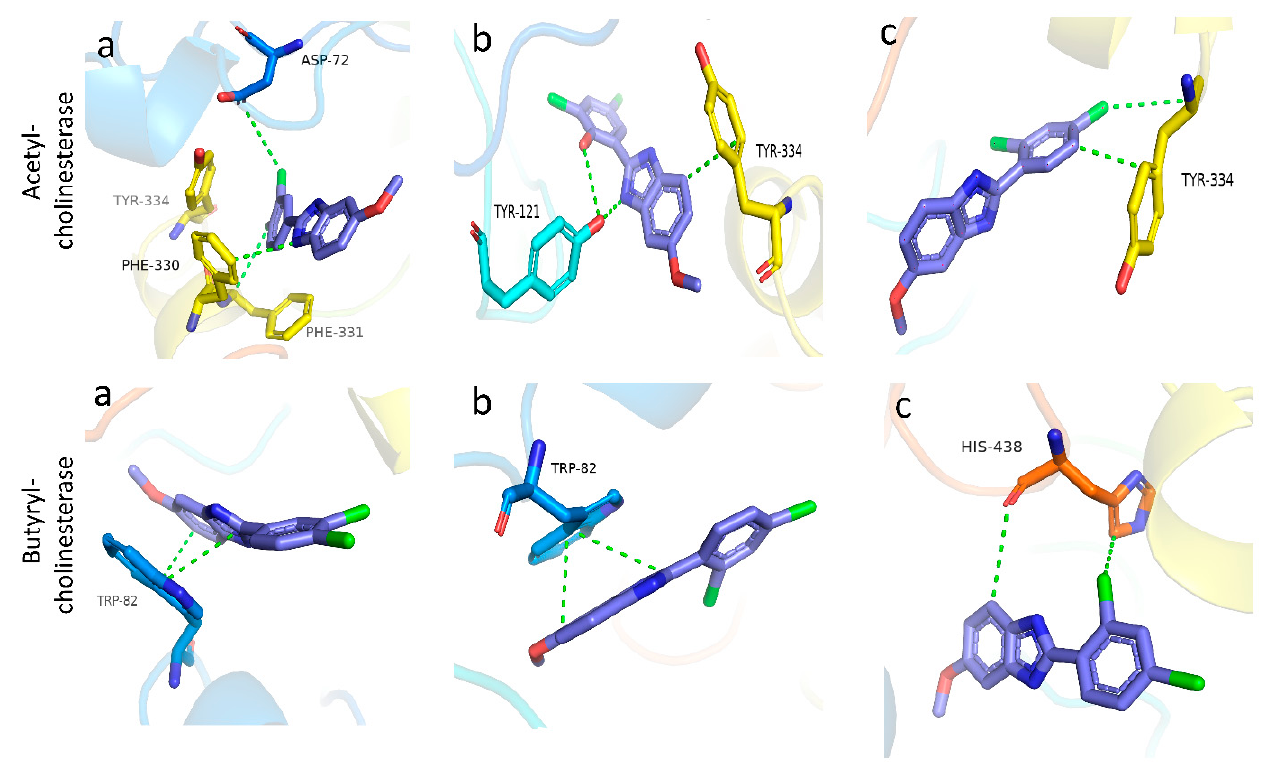
Figure 2. Docking interactions of the most active compound in the series, is for 3, 10 & 11 against the AChE ( a – c ) and BuChE ( a – c ). Green dotted line represents the bond.